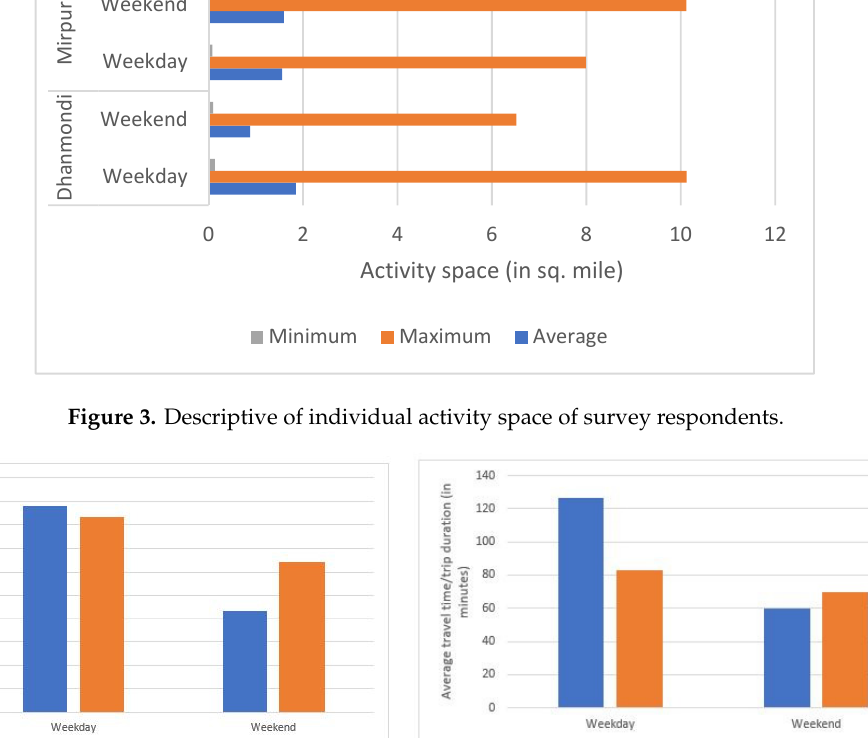
( b ) Figure 5. Gender-based comparison of ( a ) perception and ( b ) actual behavior in choosing mode to workplace. In Figures 6 and 7, activity-travel pattern visualizations for all seven days (day wise percentage of trips by trip purpose and modal share analysis) were created to analyze the variation of trip purposes and travel modes. The percentage share of trips by purpose for all seven days was mostly similar among weekdays (day 1 to 5) and between two weekend days; day 6 and 7 (Figure 6). Work trips comprise a significant share of all trips as previously mentioned. School trips are also another major trip type for Dhaka. Return trips to home were found to represent the most common purpose